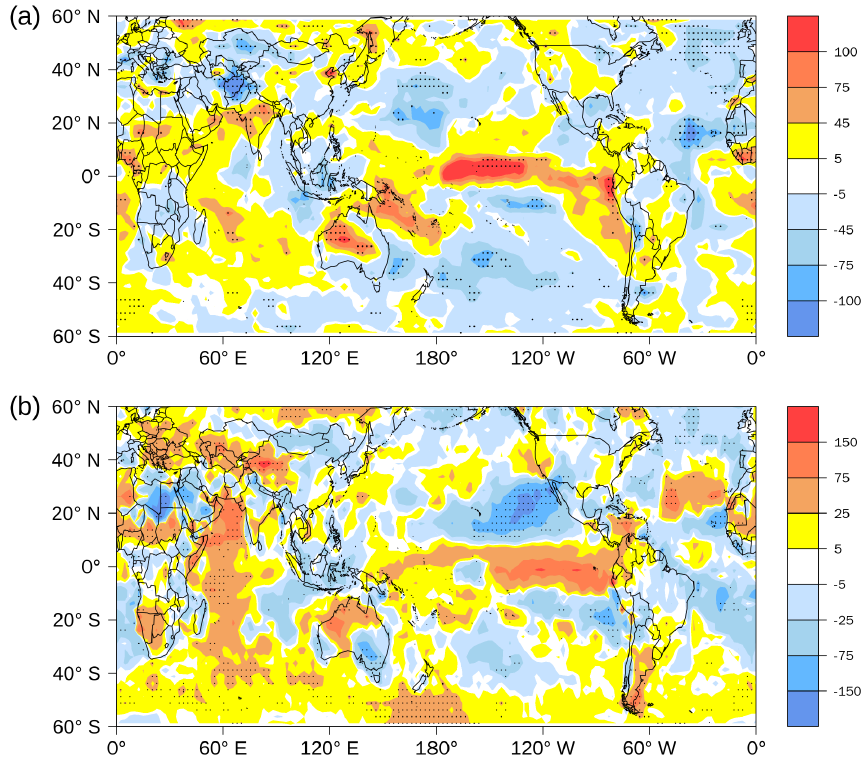
Figure 4. (a) Slope of linear regression between total cloud cover and global temperature anomalies (units: %K − 1 ) at individual grids from the corrected ISCCP D2 data set (1983–2009). (b) Slope of linear regression between annual total precipitation and global temperature anomalies (units: %K − 1 ) at individual grids from GPCP pentad V2.2 (1983–2009). Dots indicate changes significant at the 95% confidence